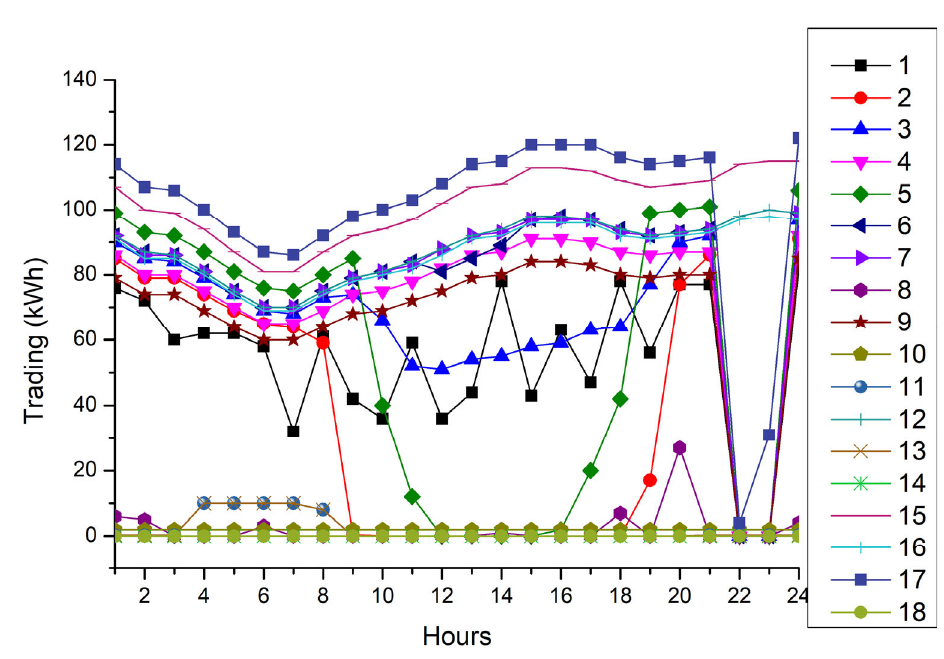
Fig. 6 . Electricity trading between peer 19 (the DC) and the rest of them. P2P